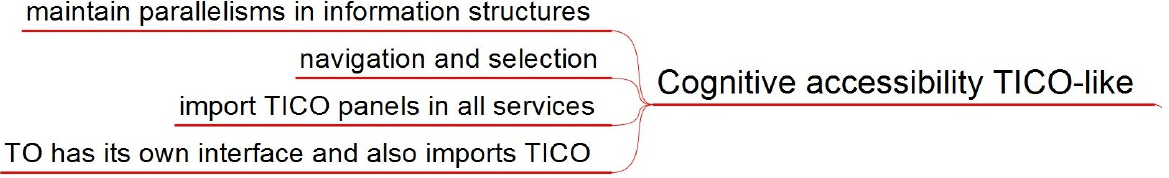
Figure 2. Services requirements for cognitive support through the use of an AAC.